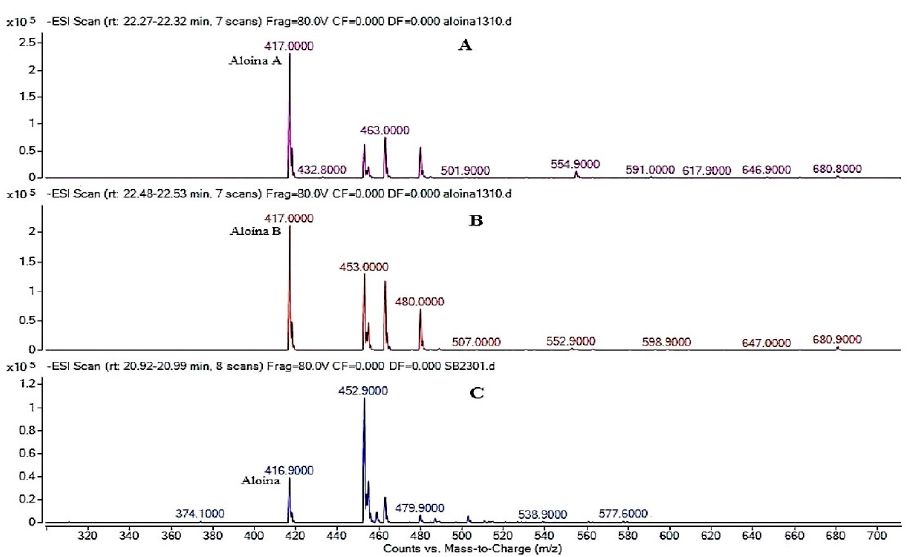
Figure 1. Chromatograms of Aloin ( A ), Aloe barbadensis extract (EA) ( B ), and washing of polyacrylamide-methylcellulose hydrogels containing the Aloe barbadensis extract (HD-PM-EA) 2% ( C ), and 1% ( D ).